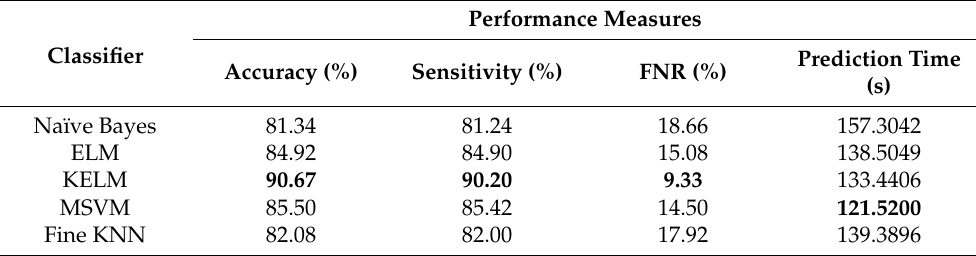
Table 4. Proposed multiple skin lesion type classification results using HAM10000 dataset. Best values are shown in bold.